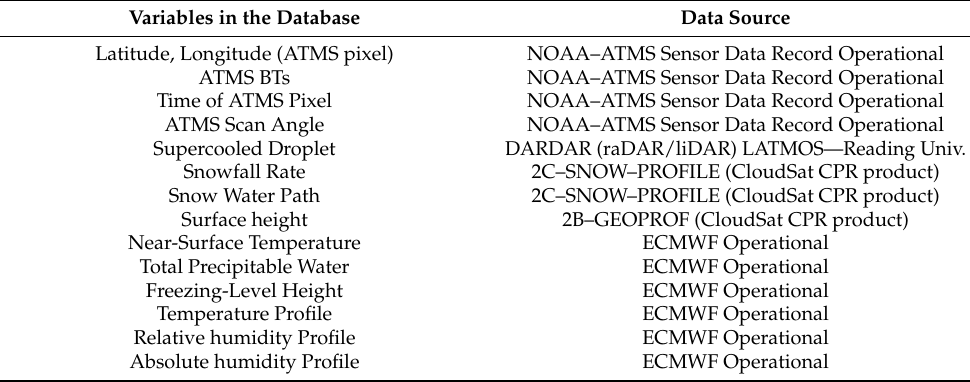
Table 3. List of variables in the ATMS–CPR dataset. Variables in the